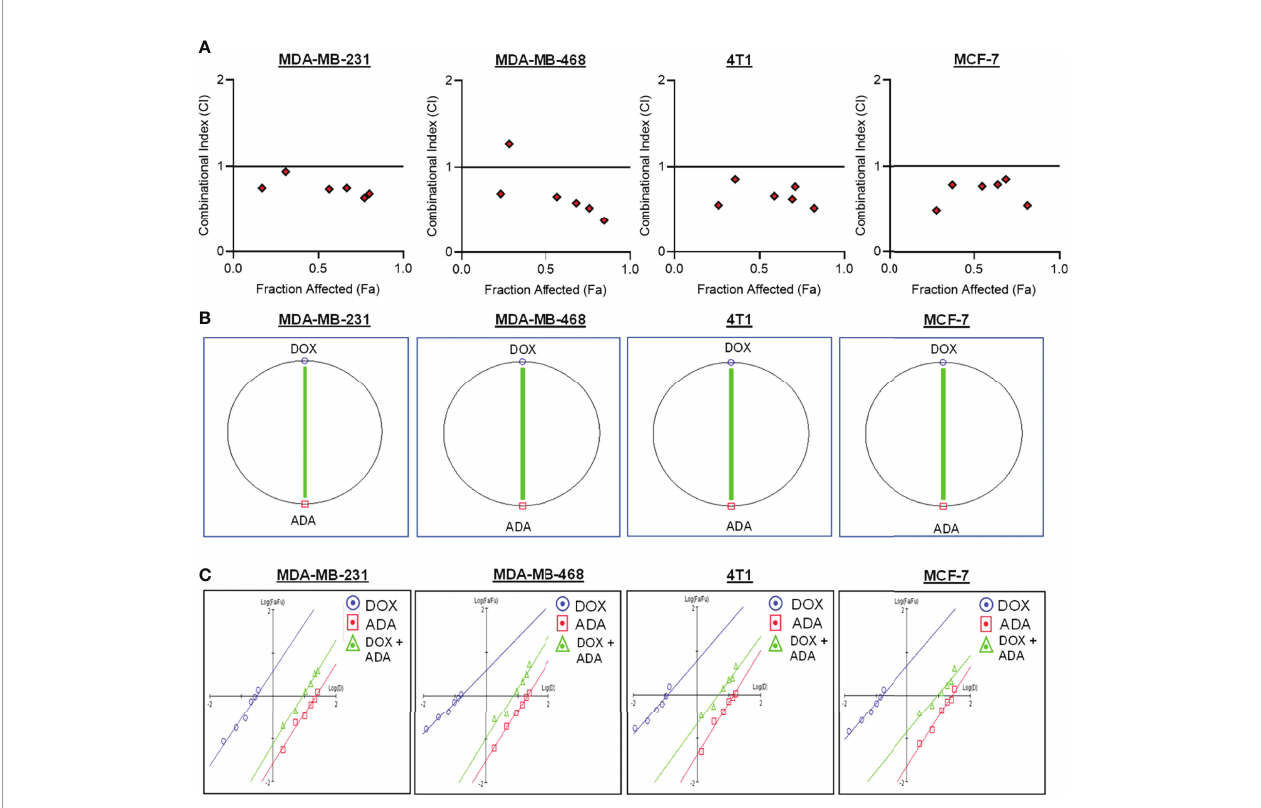
FIGURE 2 | Doxorubicin and adapalene show synergistic pharmacodynamic interactions in BC models. (A) Combination Index (CI) plots of MDA-MB-231, MDA- MB-468, 4T1 and MCF-7 cells. The CI plots showed signi fi cant synergism between ADA and DOX in TNBC and ER+ MCF-7 cells. (B) Polygonograms of MDA-MB- 231, MDA-MB-468, 4T1 and MCF-7 cells. (C) Median Plots of MDA-MB-231, MDA-MB-468, 4T1 and MCF-7 cells.